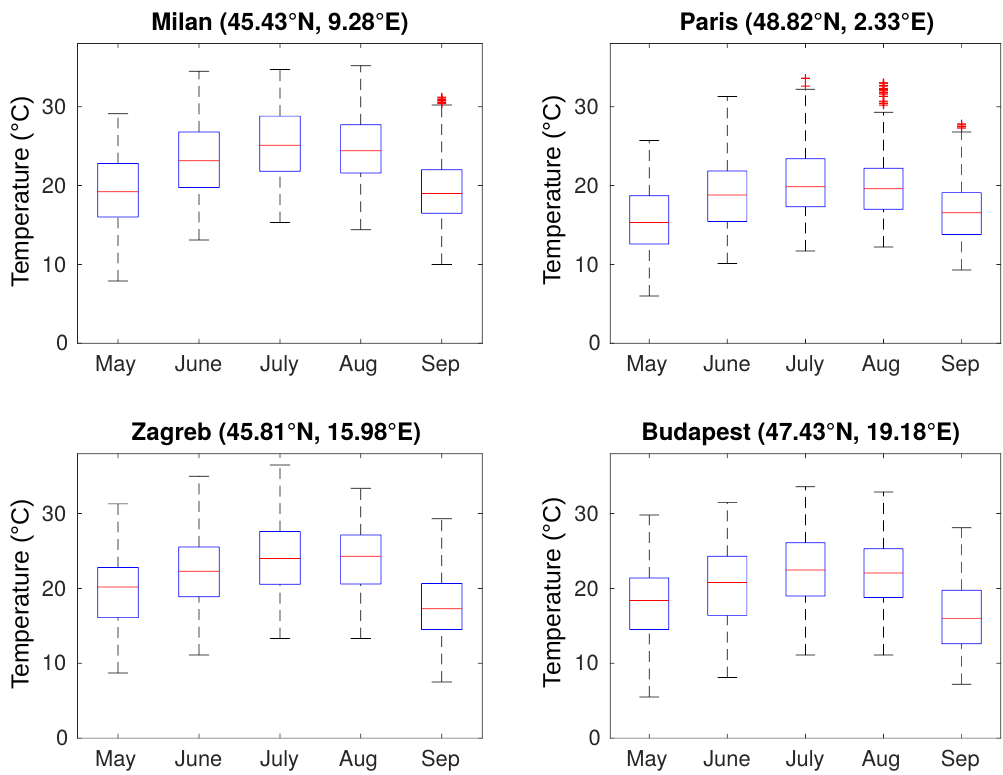
Figure 6. Outdoor air temperatures in the cities located between the 45th and 50th